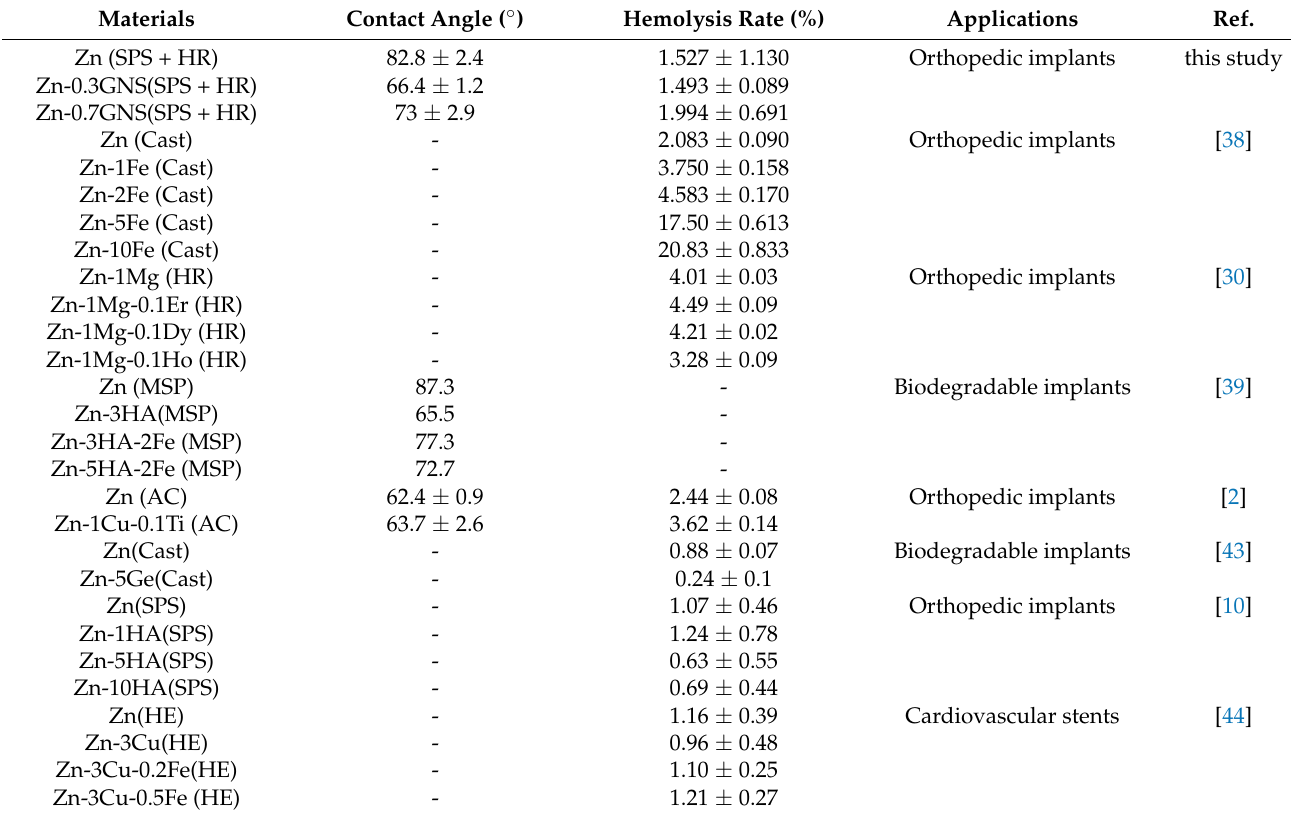
Table 1. Hemolysis rate and contact angle of various zinc matrix